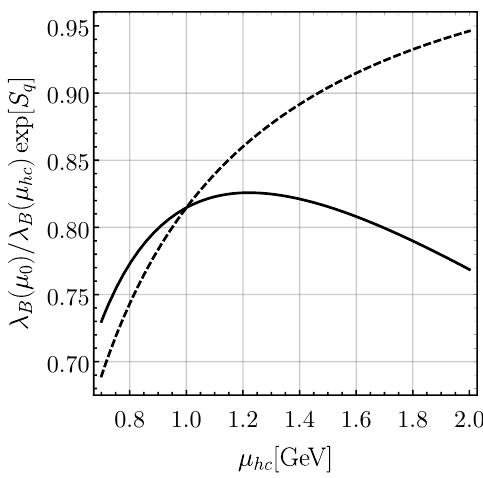
Figure 5. The SCET I Sudakov factor (cid:21) B ( (cid:22) 0 )